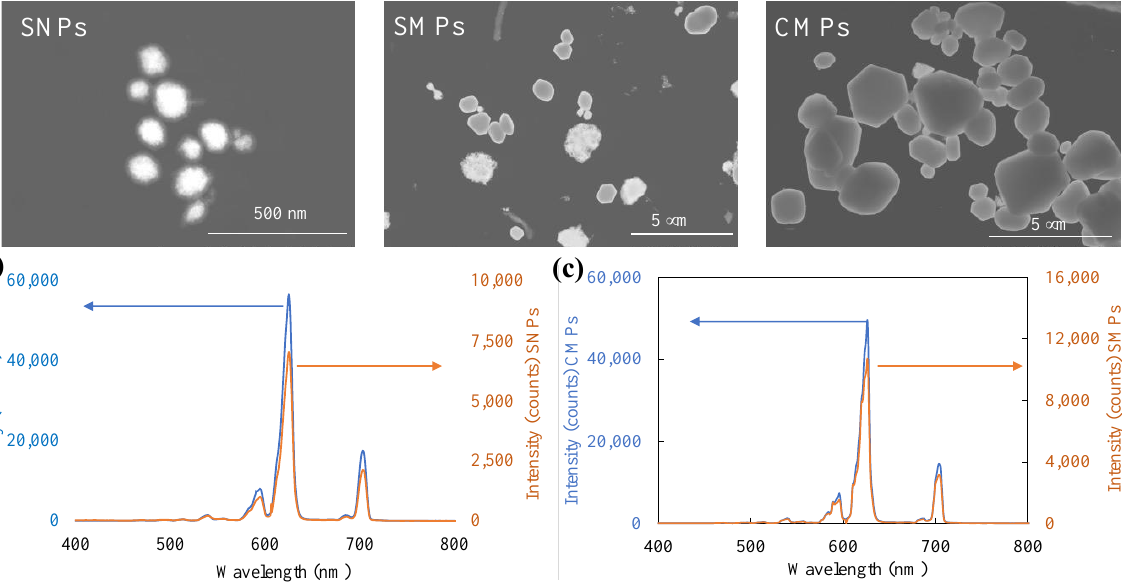
Figure 3. Particles separation via spontaneous sedimentation in a sucrose solution gradient column. ( a ) STEM images of Gd 2 O 2 S: Eu nanoparticles (NPs) ( left ), submicron particles (SMPs) ( middle ) separated from 2.5 m commercial Gd 2 O 2 S: Eu microparticles (MPs) ( right ) via spontaneous sedimentation in a sucrose gradient solution. The luminescence spectra of the separated Gd 2 O 2 S: Eu ( b ) NPs and ( c ) SMPs compared to those of the commercial mixed larger MPs.